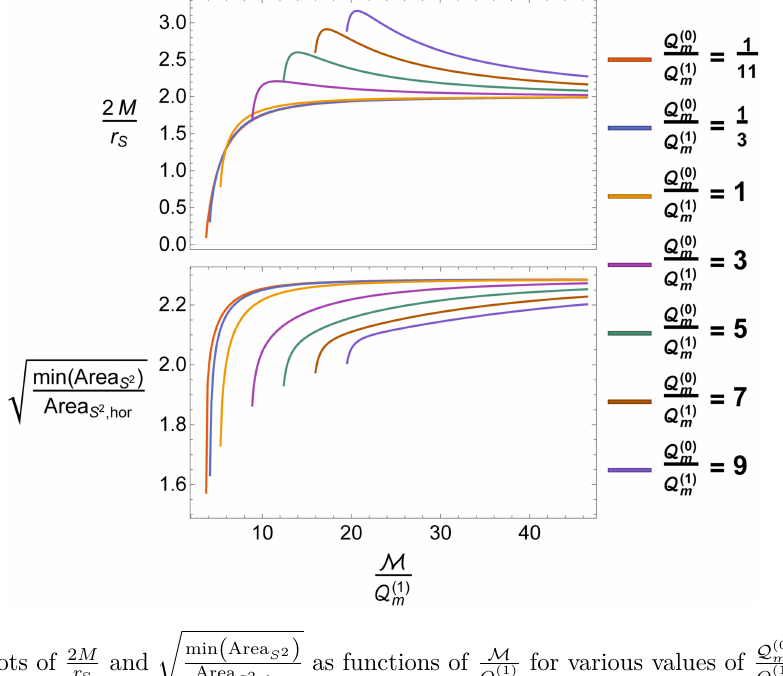
Figure 8. Plots of 2 M are in units of G space where the three-charge black brane starts to exist, and then to its extremal limit where r in